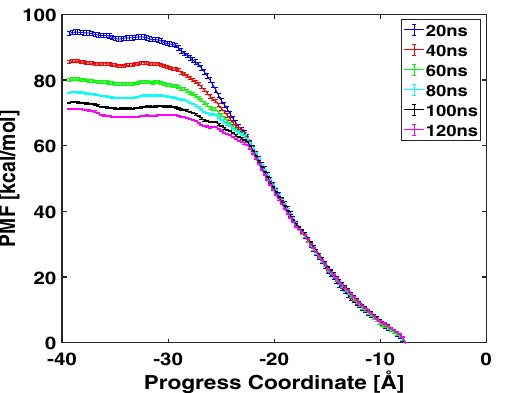
Figure 6. The potential of mean force(pmf) vs. the progress coordinate. 20 ns means that we collected the data between 0 to 20 ns (after discarding the first 20 ns data), 40 ns means 0 to 40 ns data, and so